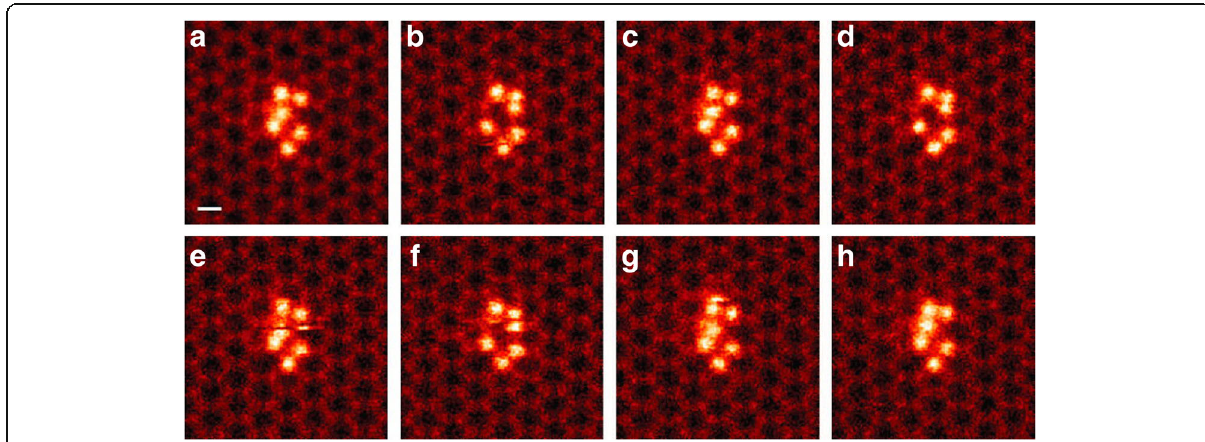
Fig. 15 Sequential STEM Z-contrast images of a Si 6 cluster embedded in a graphene pore ( a – h ). Scale bar, 0.2 nm. Reproduced from Lee et al. 2013